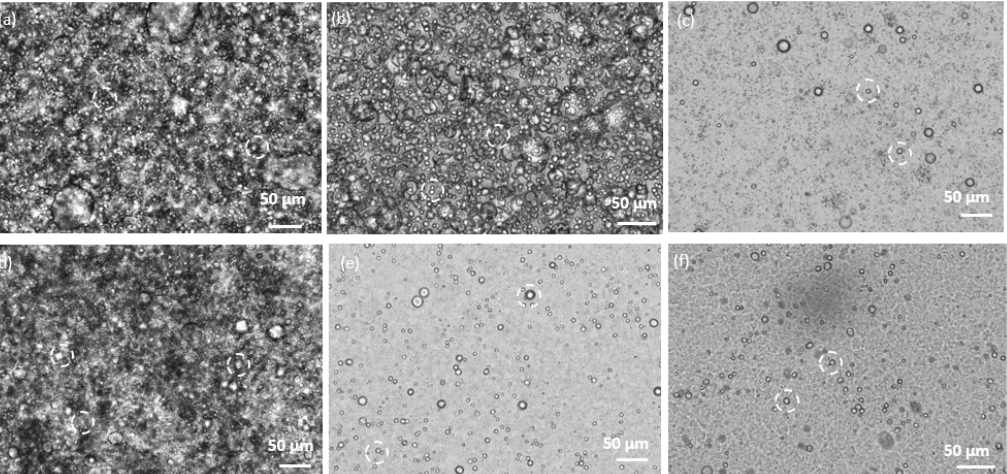
Figure 5. Light microscope images of cellulose- coated capsules containing TY ( a – c ) or EU ( d – f ) (cellulose:EO ratio 1:8), fabricated by HPH under ( a , d ) 5000 psi, ( b , e ) 10,000 psi ( c , f ) 20,000 psi. Particles are marked by dashed white circles.